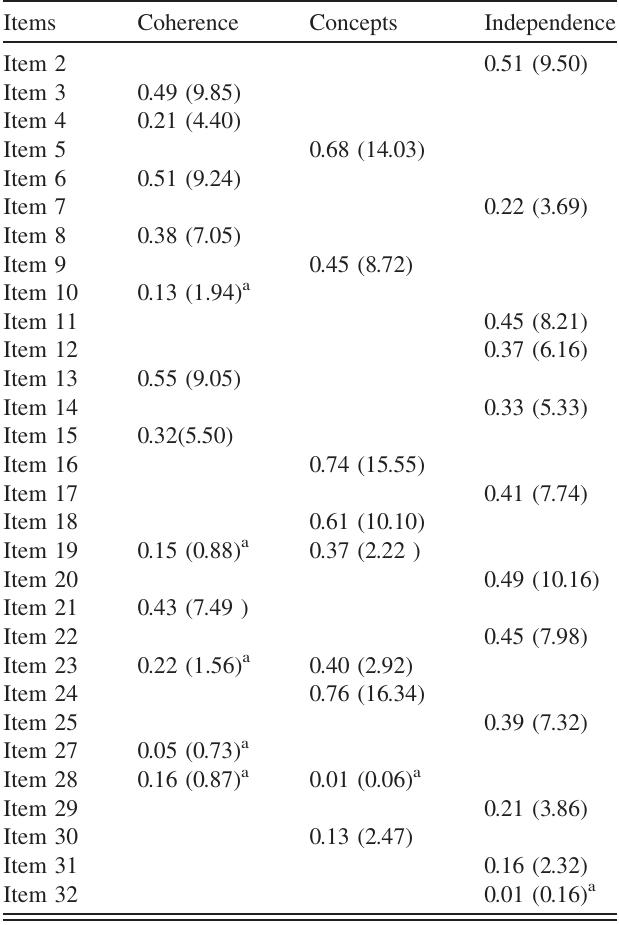
TABLE IV. Standardized factor loadings ( t values) for items of the Turkish MPEX-II. Items Coherence Concepts